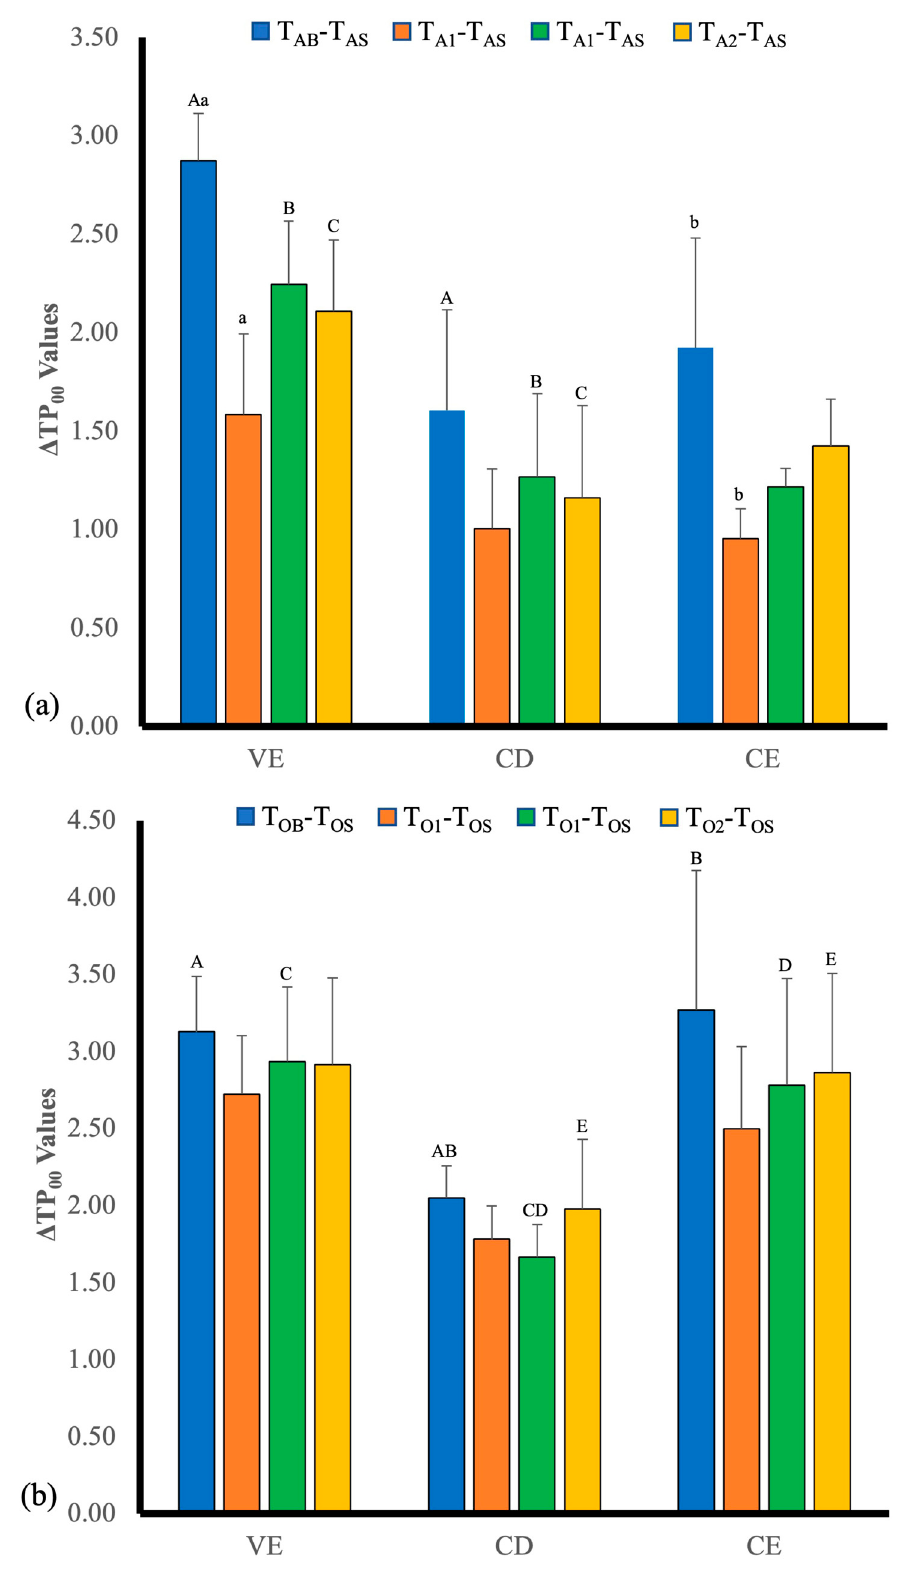
Figure 2. ∆ TP 00 values of the three materials at different times for ( a ) at-home bleaching, and ( b ) in-office bleaching. VE, Vita Enamic; CD, Celtra ® Duo; CE, Ceresmart. Subgroups identified by same superscript lowercase letters statistically differed within groups; subgroups identified by same superscript uppercase letters also statistically differed between groups ( p < 0.05).